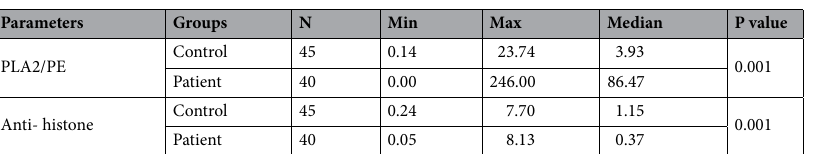
Table 3. Min., Max. and Median of PLA2/PE and anti- histone in plasma of patients with ASD compared to healthy controls. The data were statistically represented in terms Minimum, Maximum and Median as a result of normality test (the data of the presented parameters is not normal